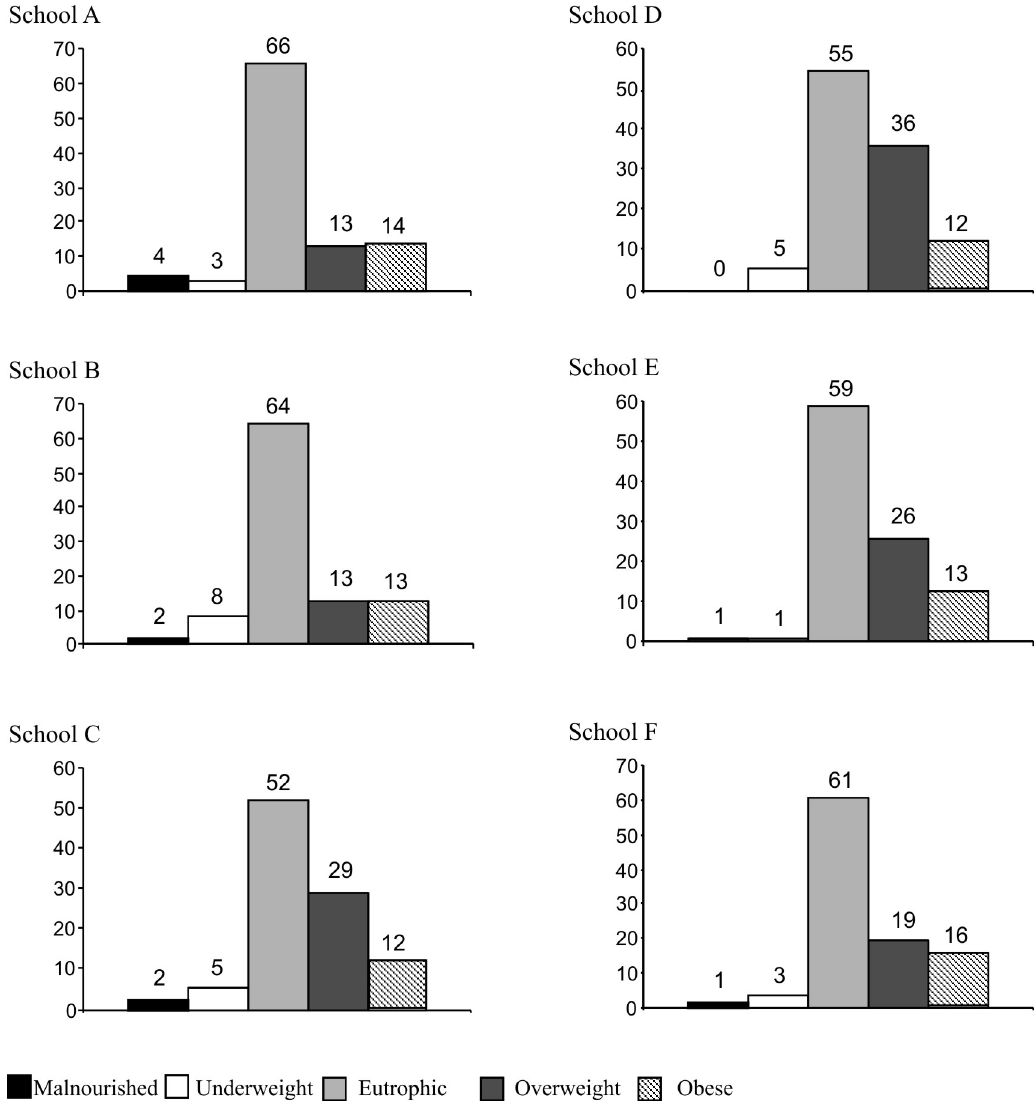
FIGURE 2 - Distribution of percentage of children of different schools according to indices of nutritional classification. Maringá – PR,